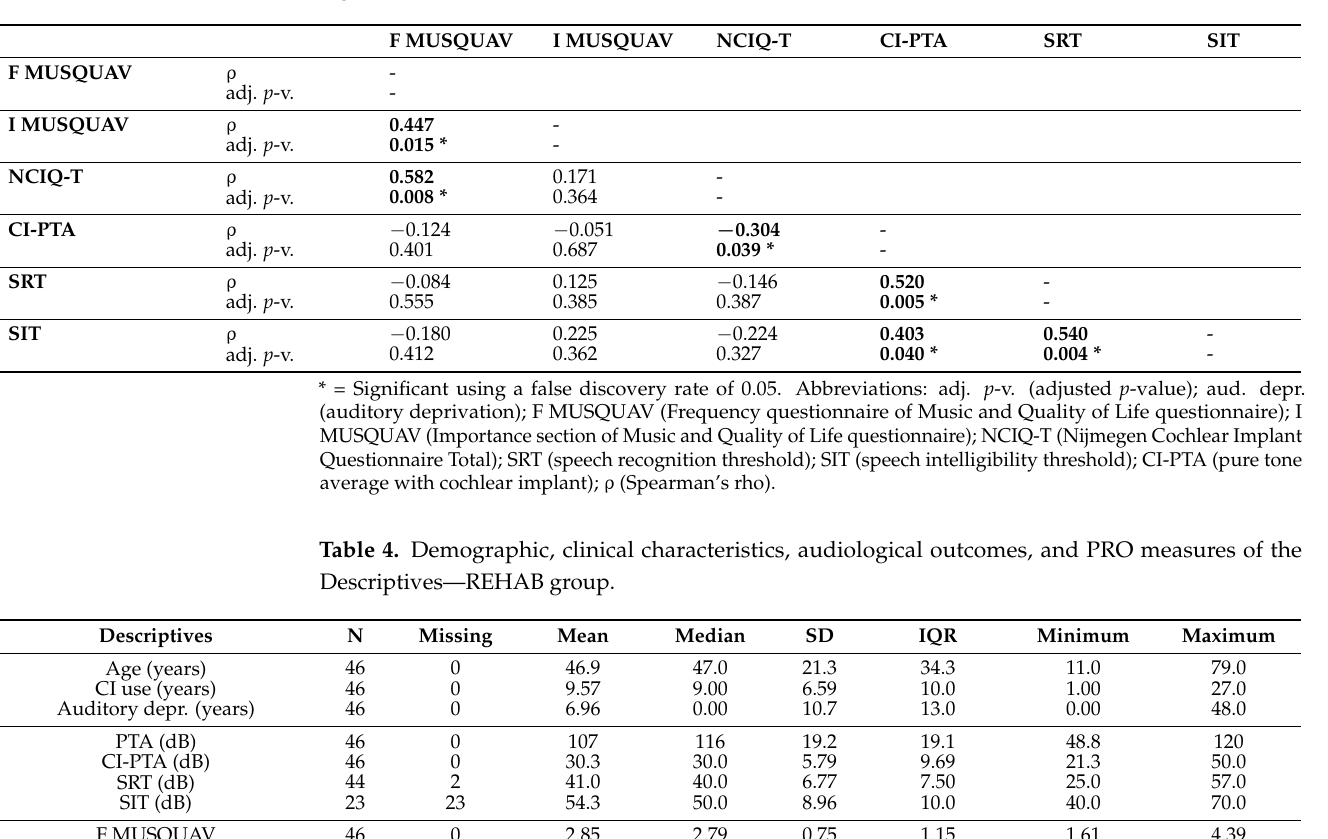
Table 3. Partial correlation matrix for PRO measures and both the clinical characteristics and audio- logical outcome.